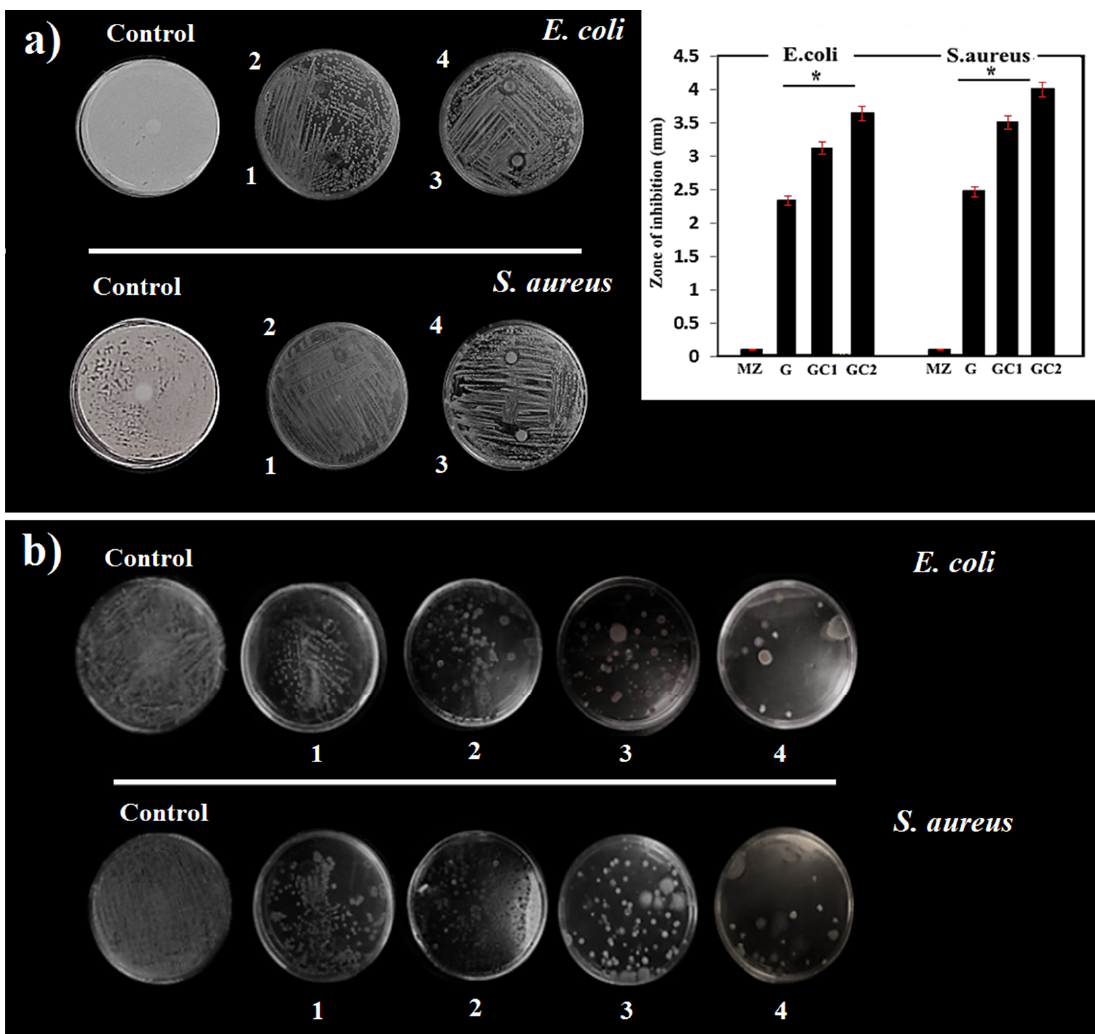
Figure 10. ( a ) Antibacterial activities of the (1) MZ, (2) MZ/GO (G), (3) MZ/1GO-Cu (GC1), (4) MZ/2GO-Cu (GC2) composites by the disk-diffusion test against both gram-positive ( S. aureus ) and gram-negative ( E. coli ), ( b ) plate count technique results of the MZ, MZ/GO and MZ/1GO-Cu composites. Note: (1): MZ, (2): MZ/GO, (3): MZ/1GO-Cu, (4): MZ/2GO-Cu (* p < 0.05).